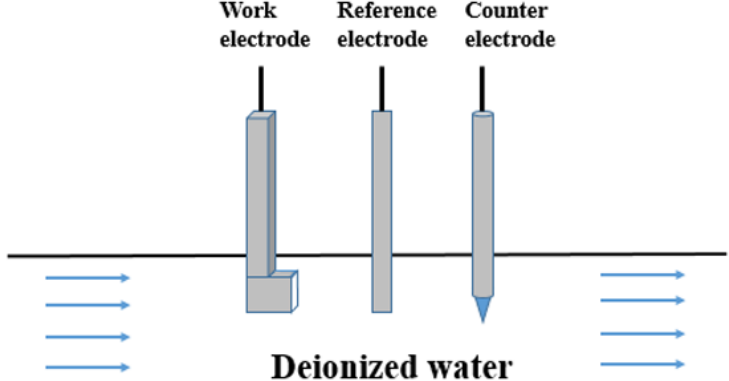
Figure 1. Diagram of the experimental device for the erosion corrosion experiment .